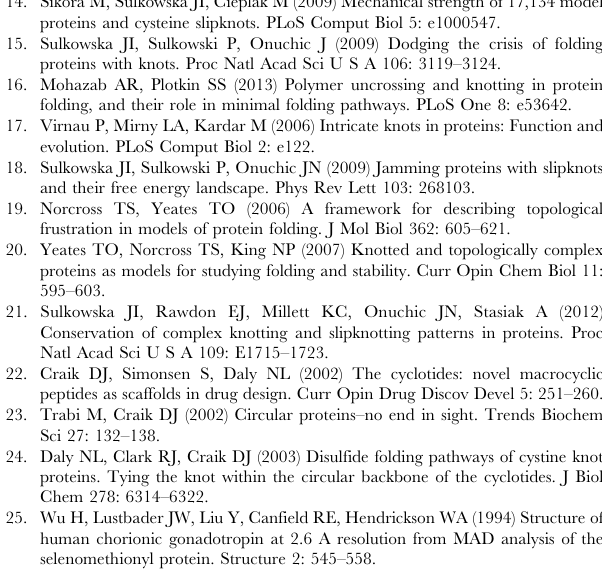
Figure S1 Phylogenetic tree of the cytokines discussed in the text. The figure shows the average distance tree using percentage identity (PID) on region from ClustalWS alignment of Retrieved from Uniprot. Data analyses indicates that these proteins emerged from a common ancestor (IFN, 2KZ1). The C-terminal PLB leptin is the newest member of the family. Figure S2 Probability of the formation of helix B. The plot shows the same data as Figure 4 where reduced protein is shown in blue and oxidized protein in red. The unthreaded proteins show the reduced state in black (full description in method section). The plots are boxed from the position of the covalent loop with a threaded element, dark blue for the C-terminal loop, light blue for the N-terminal loop and grey for the unthreaded protein (same colours are used as in Figure 4). The formation of helix B is not affected by the threaded topology where all plots shows similar trends. Figure S3 Probability of the formation of helix C. Plotted in the same way as Supporting Figure S2. Helix C seems to be influenced by the formation of the N-loop for the N-terminal PLBs where helix C forms native contacts at lower values of Q. Figure S4 Probability of the formation of helix D. Plotted in the same way as Supporting Figure S2. Helix D shows no significant changes between the oxidized and reduced states. Figure S5 The threading mechanism of C-terminal PLB leptin. (Top) The two possible threading mechanisms are observed in simulations and shown in cartoon format. Slipknotting is the major event (black). We also observe a rare event where the N-terminal plugs through the covalent loop (green). (Bottom) A plot of the progress from unfolded to native (plotted as Q, 0 to 1, respectively) versus time indicates that a slip knotting event progresses more readily to the native state than a plugging mechanism.